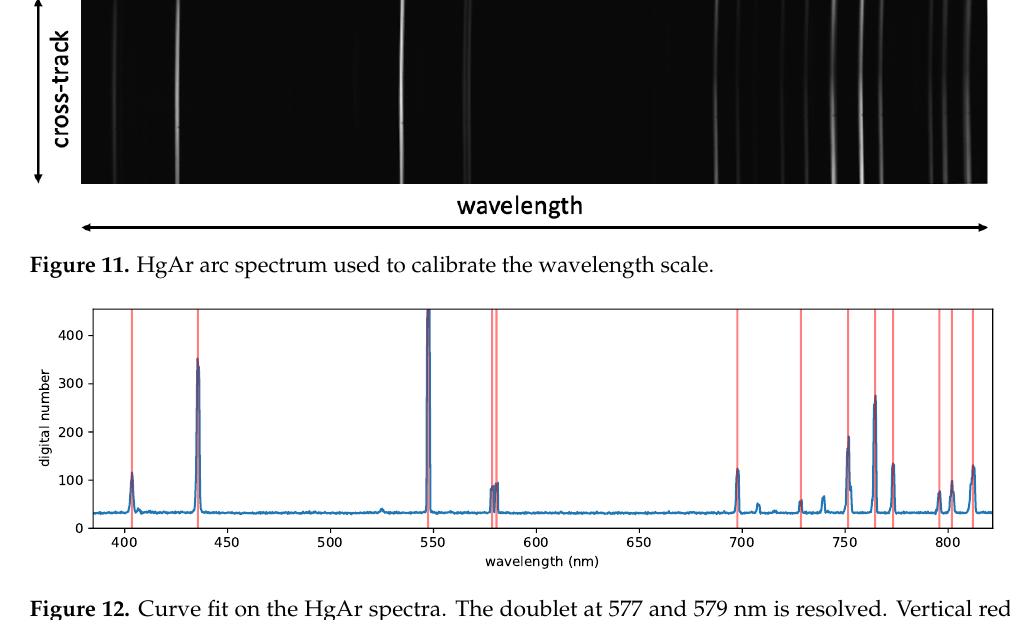
Figure 12. Curve fit on the HgAr spectra. The doublet at 577 and 579 nm is resolved. Vertical red lines indicate the peaks used in the fit. The spectral range is 384–821